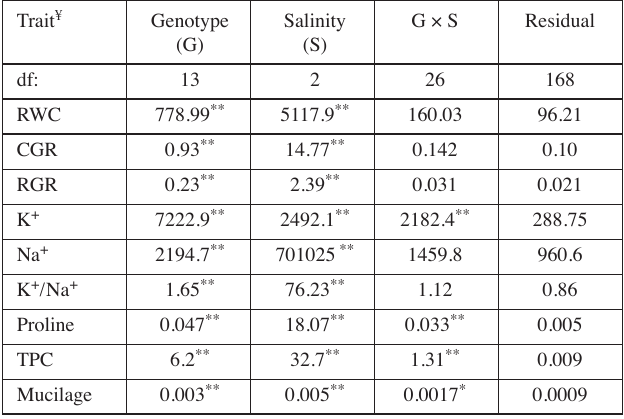
Tab. 1: The results of analysis of variance for callus related traits of psyllium genotypes subjected to salinity stress. Trait ¥